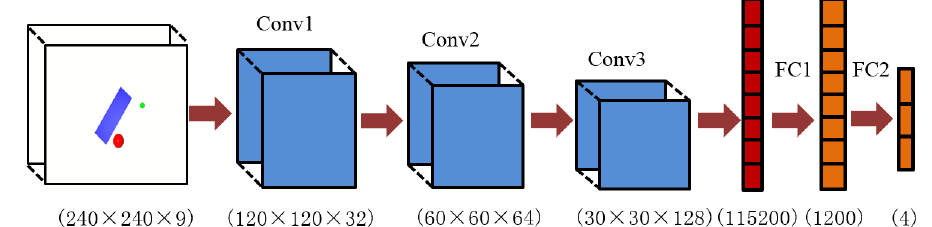
Figure 3. Architecture of the designed neural network policy. Two stride steps and a filter size of 3 × 3 are used for all three convolution networks. The ReLU nonlinear activation function is used throughout, with no pooling and no dropout techniques applied. The input is three RGB images from a simulated environment downsized to (240 × 240) with 9 channels, and the output is